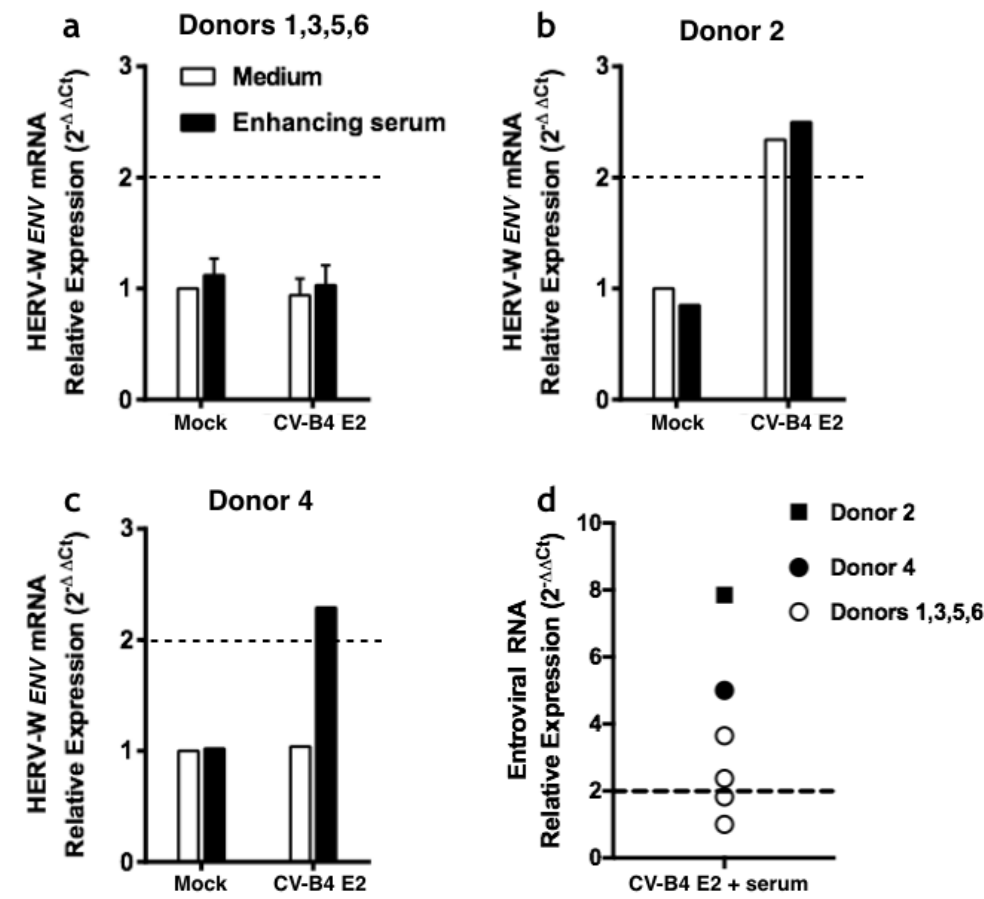
Figure 4. Relative expression of Human Endogenous Retrovirus W Envelope (HERV-W ENV ) and enteroviral RNA in peripheral blood mononuclear cells (PBMCs) after inoculation with coxsackievirus B4 (CV-B4). PBMCs were isolated from bu ff y coats of six healthy donors and inoculated with CV-B4 E2 at multiplicity of infection 1 or with CV-B4 E2 mixed with human immune serum (dilution 1 / 1000), followed by incubation for 4 h. Thereafter, the cell layers were rinsed three times and incubated overnight. The cell layers were then washed once to eliminate non-adherent cells, and adherent cells were recovered to determine the level of HERV-W ENV mRNA and enteroviral RNA using RT-qPCR after normalization with beta-actin mRNA expression. For each condition, the result, which is the mean of two determinations, is the relative expression of the marker compared with the control calculated using the 2 – ∆∆ Ct method. Relative expression of HERV-W ENV mRNA in PBMCs from ( a ) donors 1, 3, 5, and 6 (mean ± SD), ( b ) donor 2, and ( c ) donor 4. ( d ) Individual representation of relative expression of enteroviral RNA in PBMCs of donors